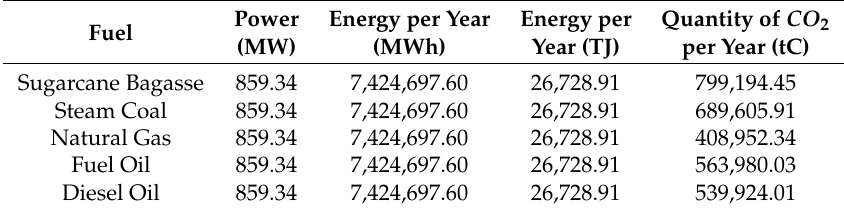
Table 10. CO 2 emission by fuel type for production of 859.34